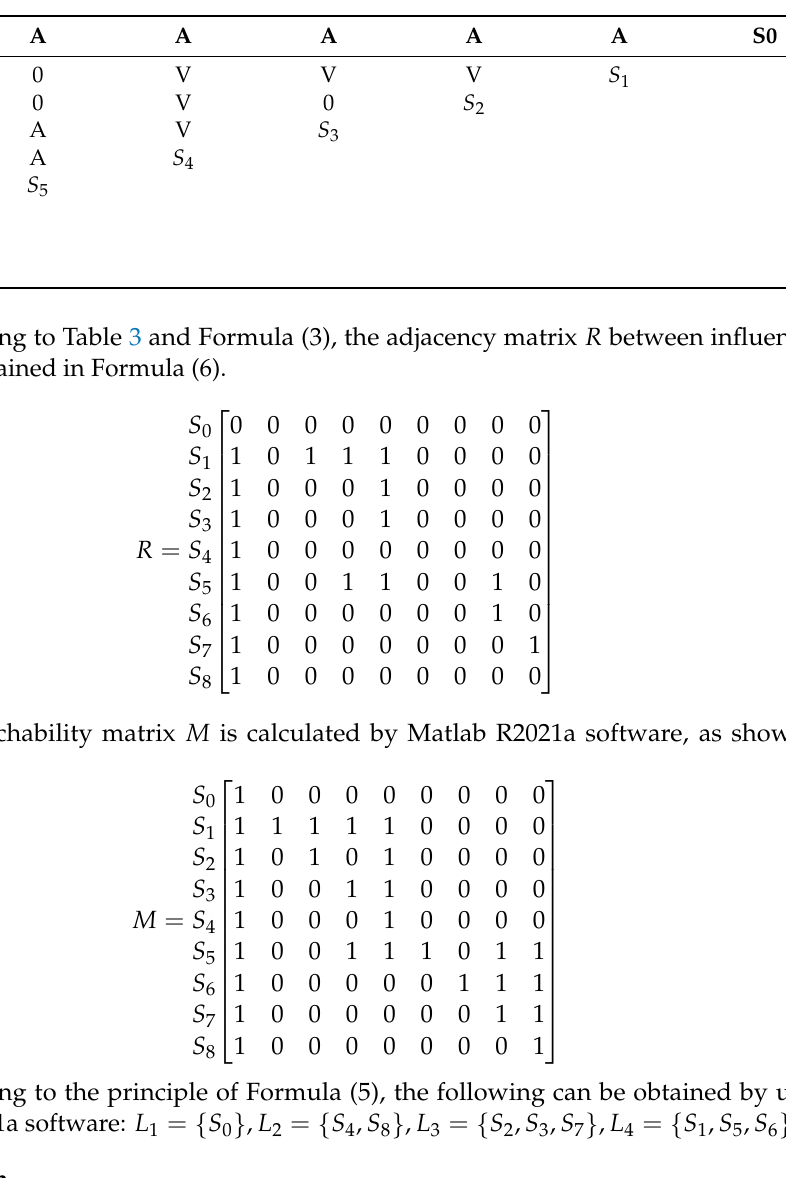
Table 3. Logical relationship of influencing